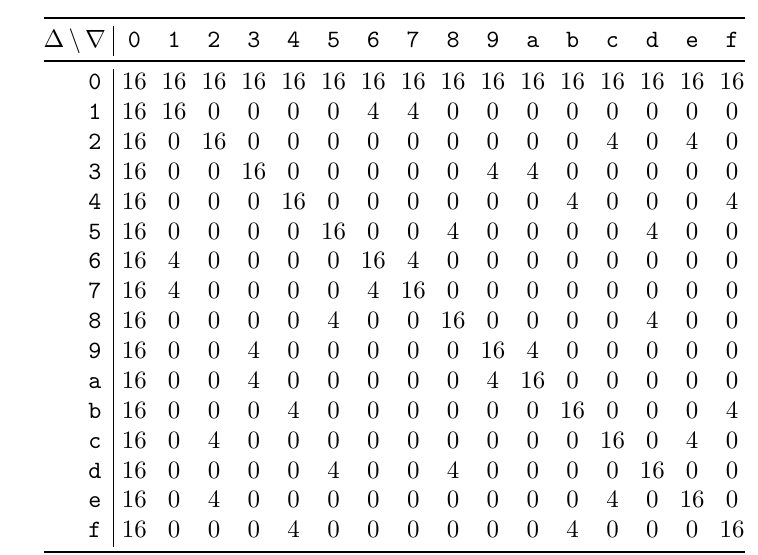
Table 8: FBCT of TWINE ’s S-box.